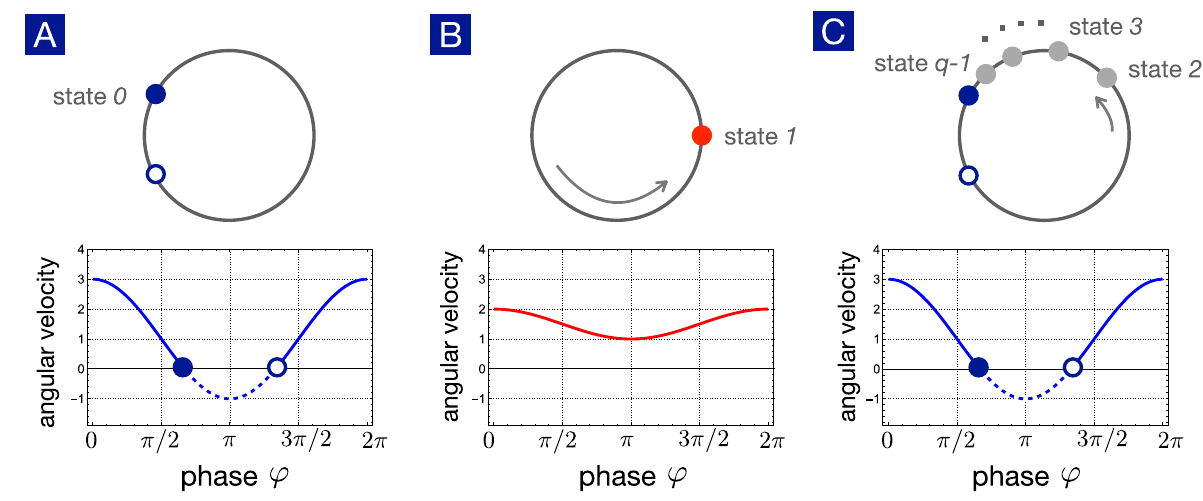
Figure 10. Kinouchi-Copelli neuron as the U(1) neuron in discrete time steps. ( A ) Without external stimuli, the neuron is excitable with a stable fixed point (state 0) denoting the resting state. ( B ) In the presence of external stimuli, by either external or synaptic currents, the neuron fires and the phase swings to ϕ = 0 with maximum potential. ( C ) After firing, the neuron enters the refractory states denoted by states 2, 3, · · · , q − 1 and eventually returns to the rest